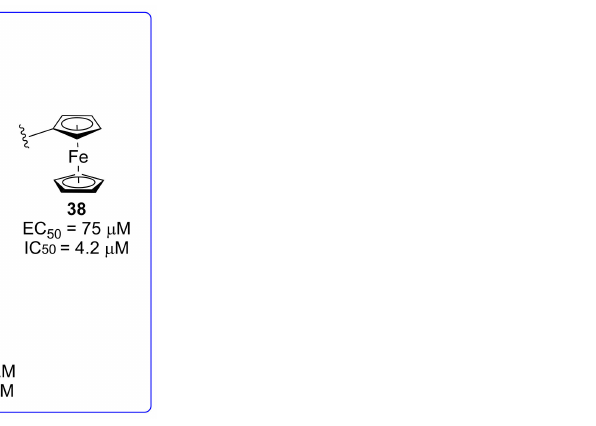
Figure 9. Structure of TR inhibitors. EC 50 is the ability of compounds to inhibit MCF-7 growth while IC 50 refers to the anti-TR activity.